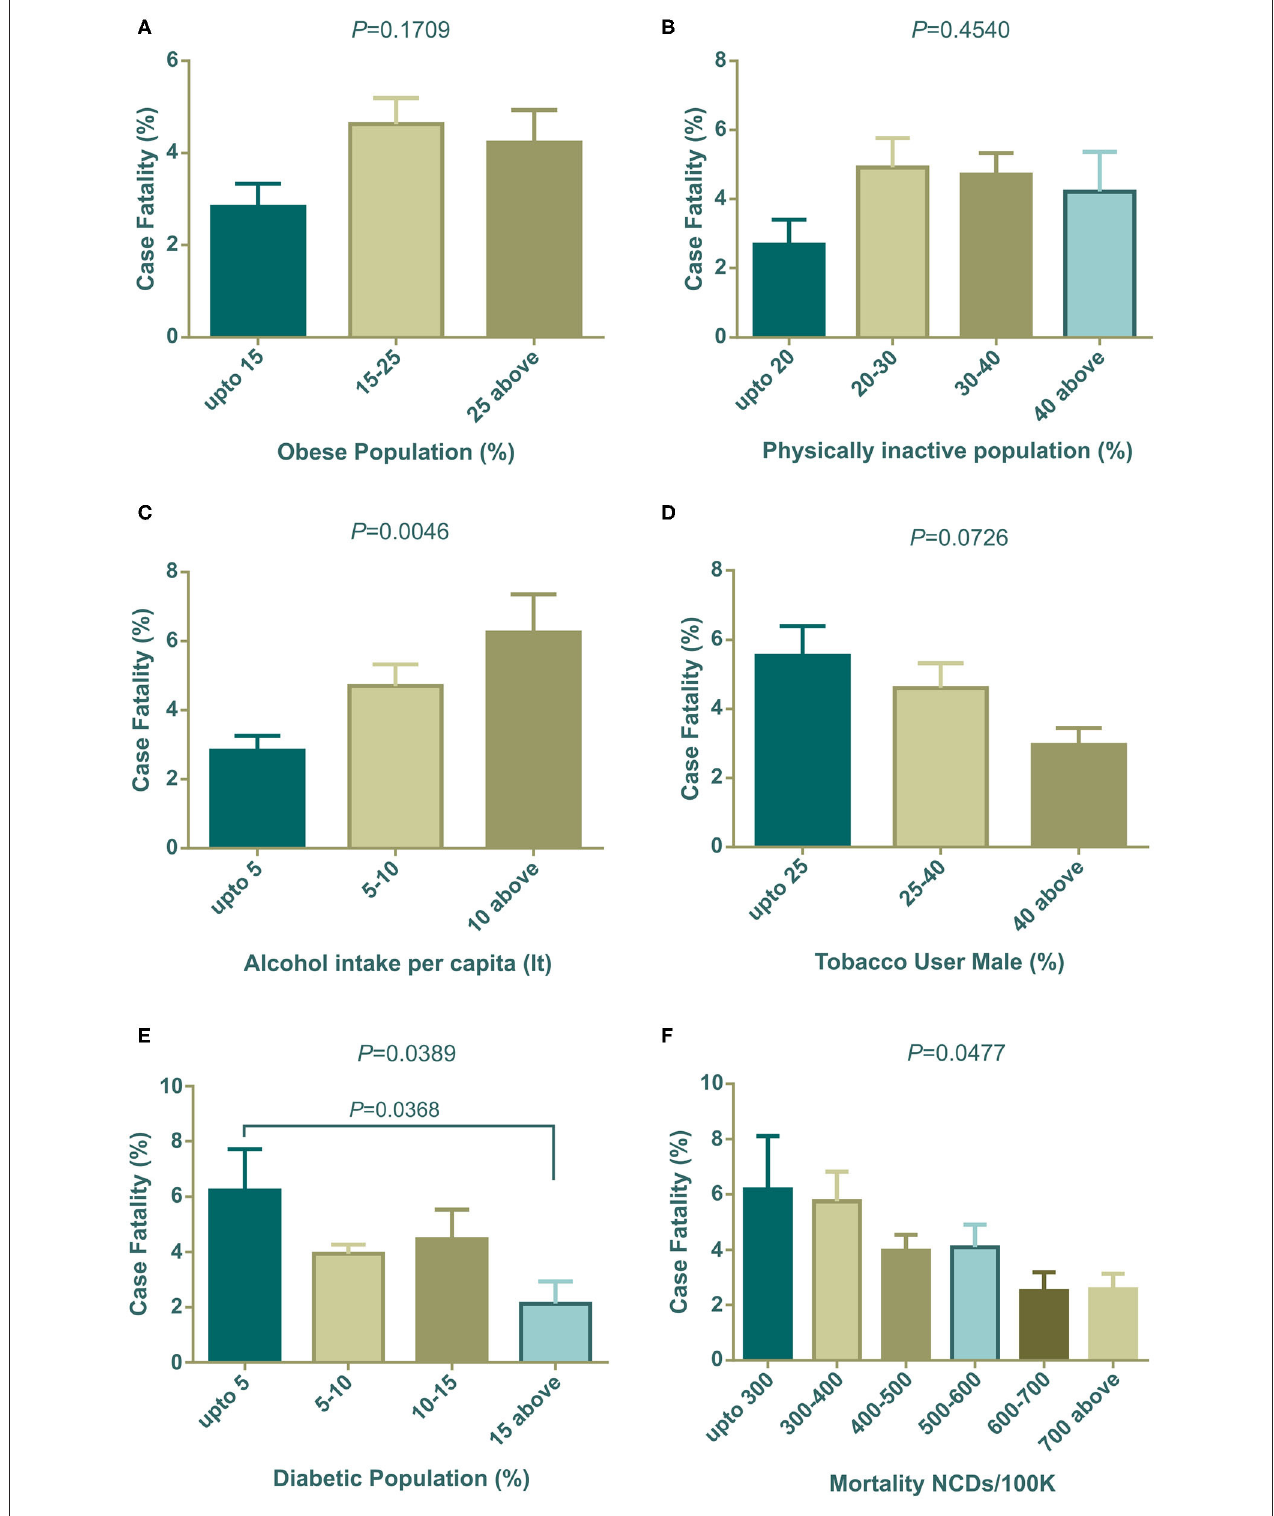
FIGURE 4 | COVID-19 case fatality (%) distribution based on countries grouped according to health indicators (A–F) . Alcohol intake, diabetic population, and NCDs mortality/100K were statistically significant by one way ANOVA. Data presented are mean ± SEM.